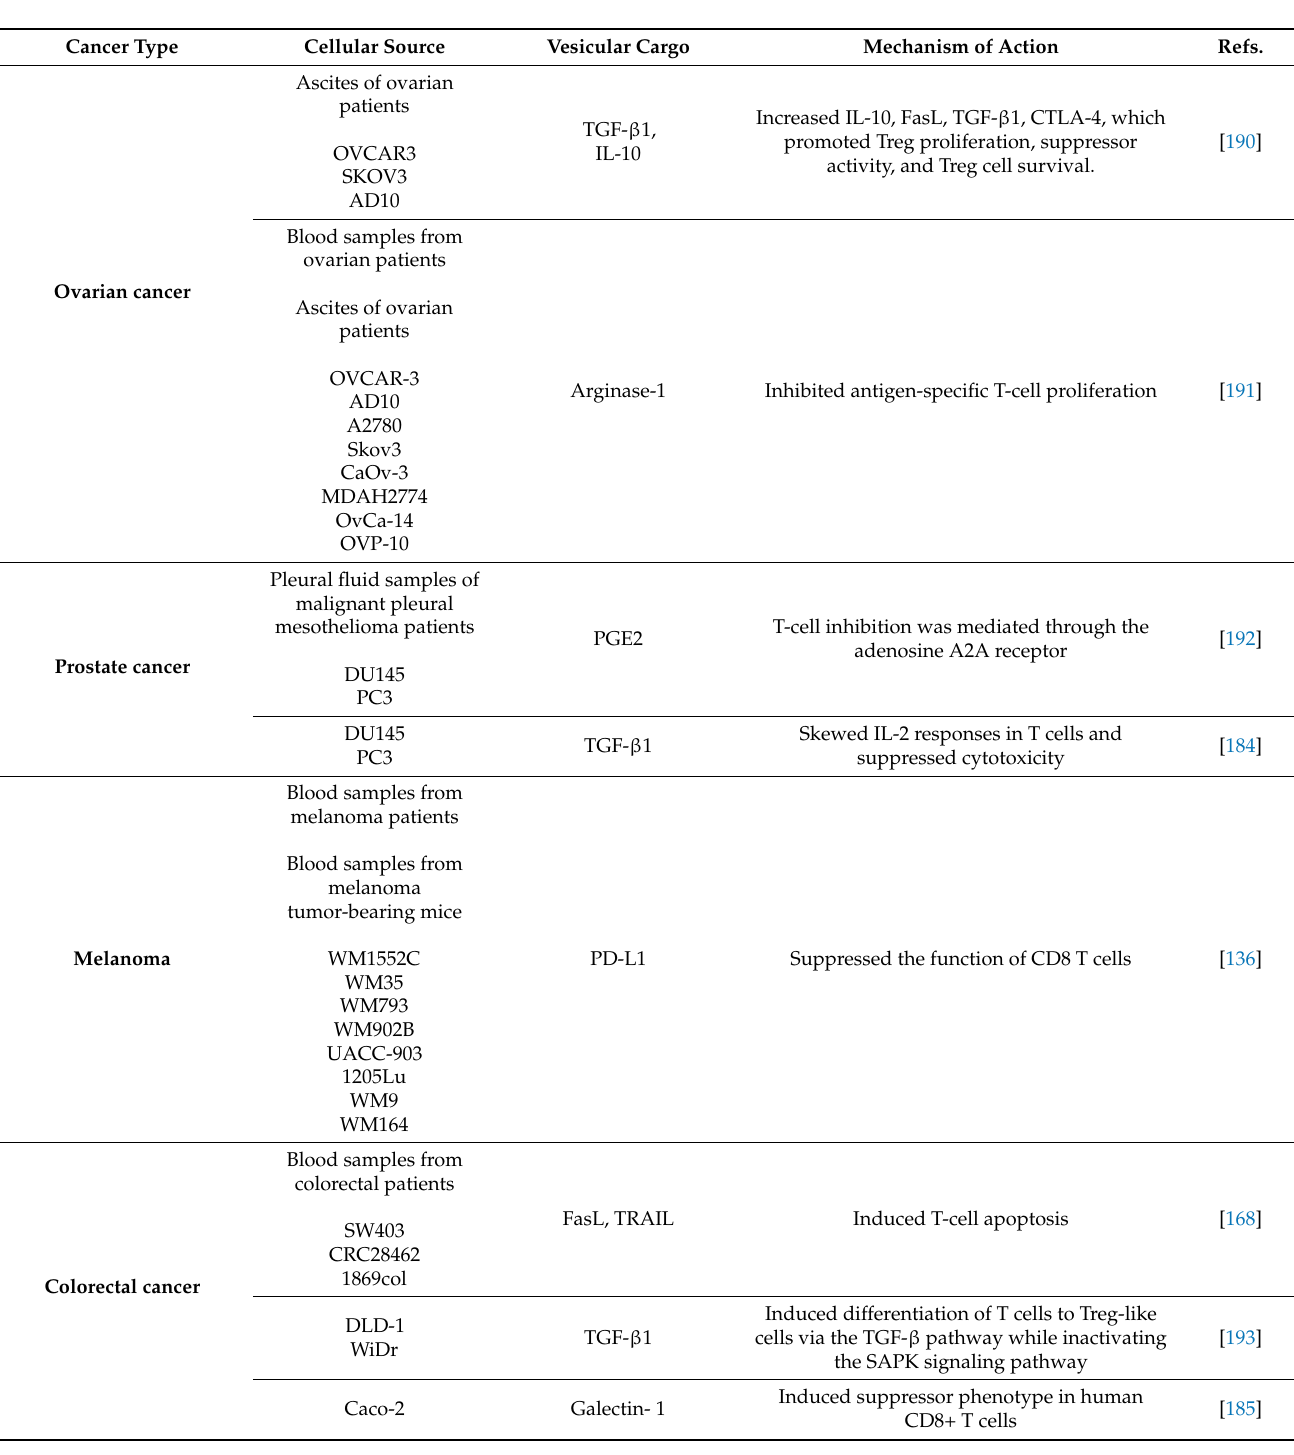
Table 5. Effect of the tumor-derived extracellular vesicles on T